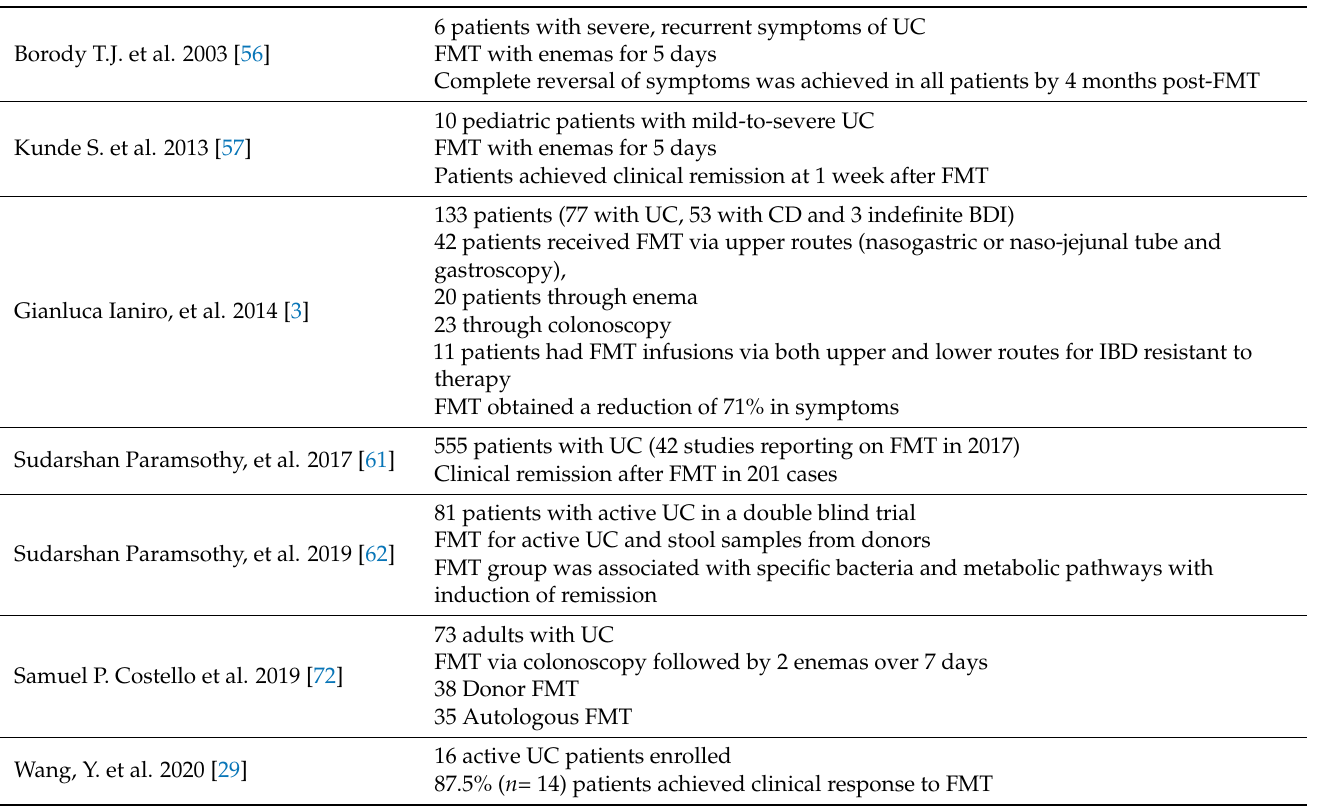
Table 2. Studies of FMT in